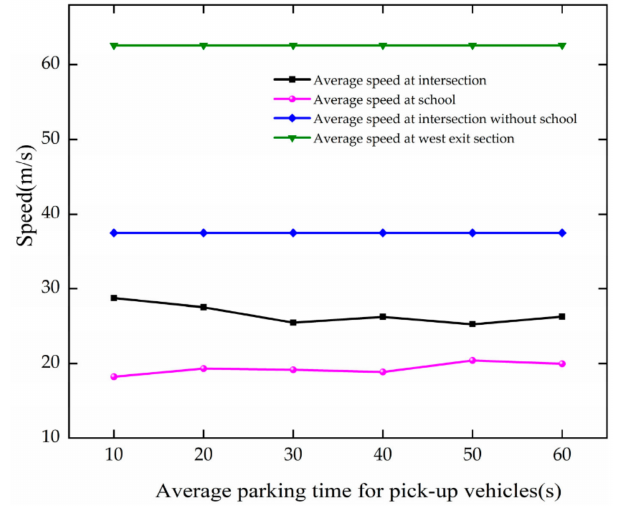
Figure 28. Variation trend of average speed with APT.